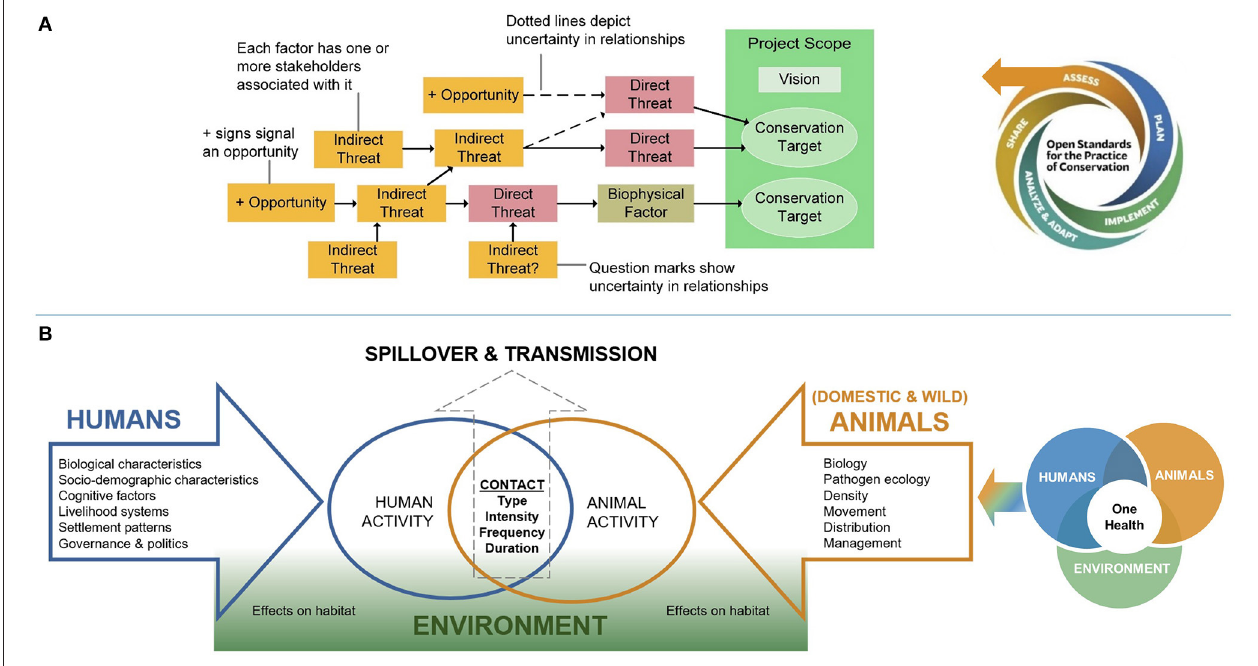
FIGURE 2 | (A) Open Standards conceptual model representing socio-ecological factors identified in a cross-disciplinary situation analysis [CMP (Conservation Measures Partnership), 2020 ]. (B) One Health model of zoonotic disease transmission, showing the determinants of human and animal activities and the environment that affect human-animal exposure to zoonotic disease transmission (adapted from Woldehanna and Zimicki,